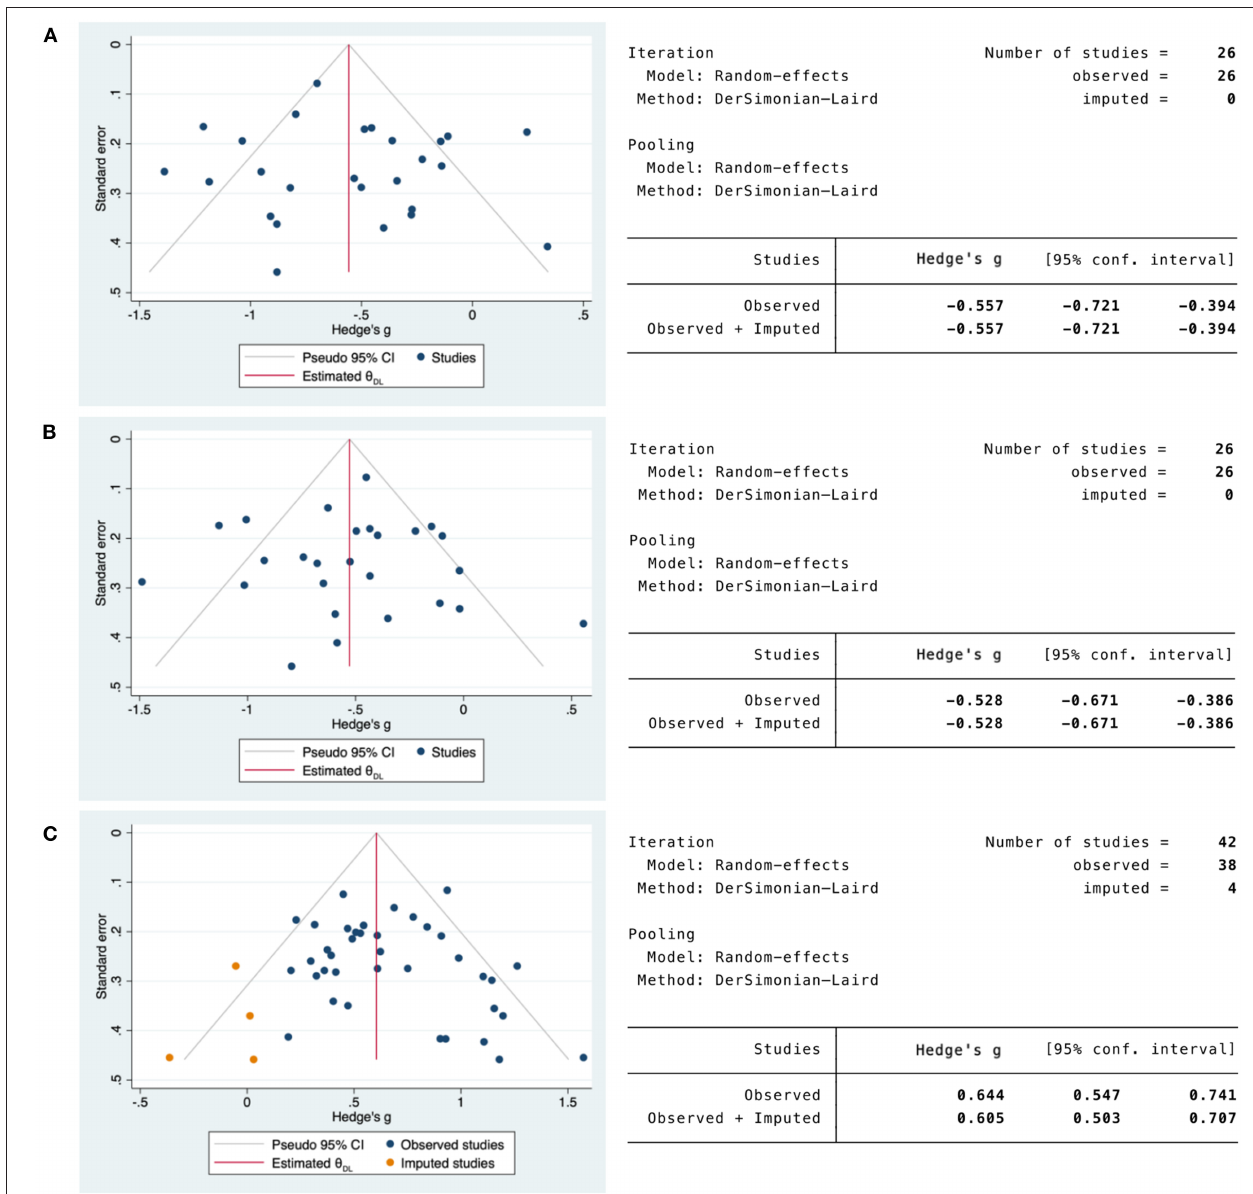
FIGURE 7 | Non-parametric trim and fill funnel plot analysis of publication bias for CD4/CD8 T-cells and IL-10 in COVID-19 severity studies. (A) CD4 T-cells in COVID-19 severity studies. (B) CD8 T-cells in COVID-19 severity studies. (C) IL-10 in COVID-19 severity studies. Observed studies (blue). Imputed studies (orange).